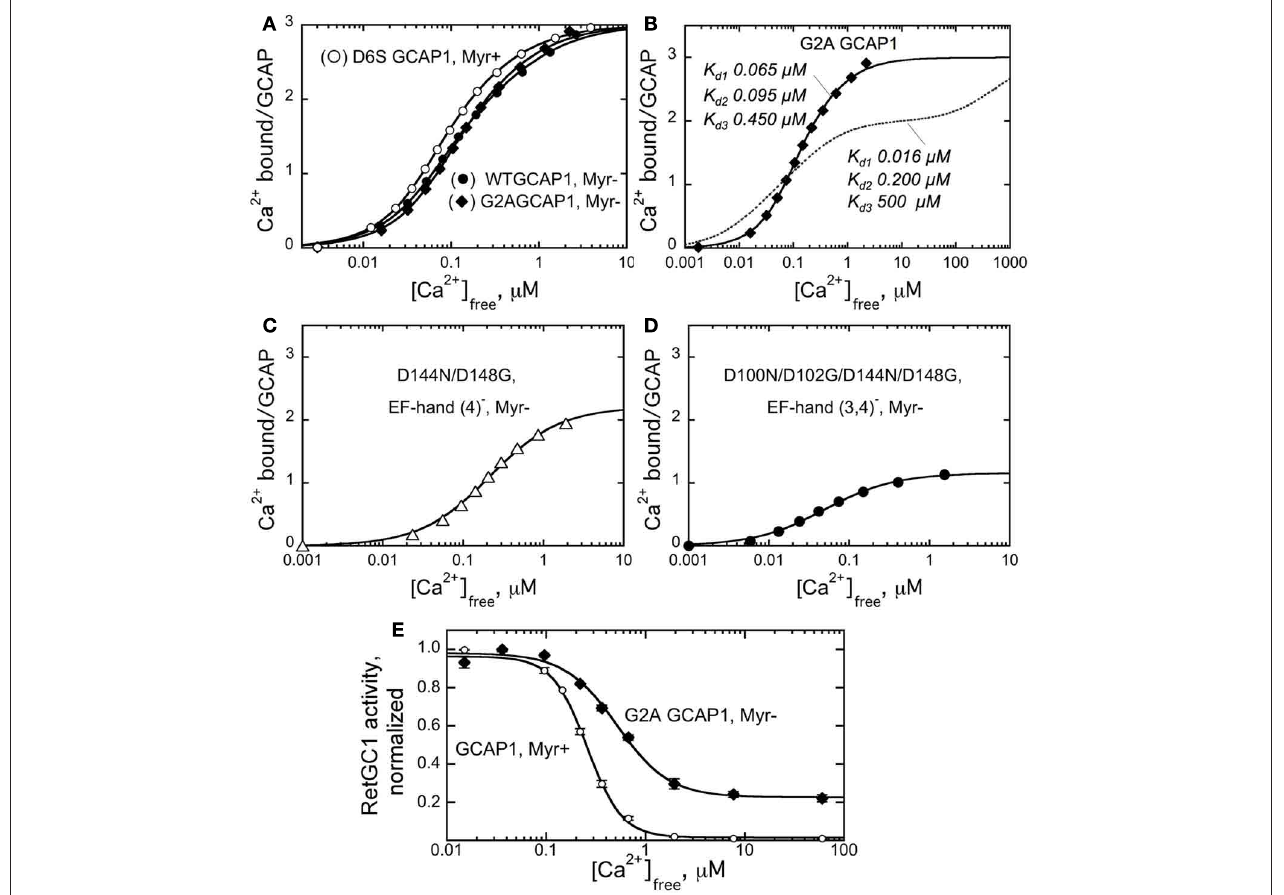
FIGURE 3 | Ca 2 + sensitivity of GCAP1 is affected by myristoylation. (A–D) , Ca 2 + binding isotherms obtained using fluorescent indicator dye BAPTA-2 titration protocol (Peshenko and Dizhoor, 2006). (A) Ca 2 + binding by myristoylated D6S GCAP1 ( ◦ ), non-myristoylated WT GCAP1 ( • ), and non-myristoylated G2A GCAP1 ( (cid:2) ). (B) Comparison of the experimental data for Ca 2 + binding by G2A GCAP1 ( (cid:2) ) with the theoretical curve for three-center binding model calculated using previously reported macroscopic association constants, 6 . 3 × 10 7 , 5 . 0 × 10 6 , and 2 . 0 × 10 3 M − 1 (Dell’Orco et al., 2010) (- - -); the corresponding dissociation constants are shown next to each trace. (C,D) Change of the binding stoichiometry in non-myristoylated GCAP1 with one (D144N/D148G, C ) or two (D100N/D102G/D144N/D148G, D ) EF-hands inactivated. The data were fitted using two different models: panels (A,B) —by three-center binding model, Ca bound /GCAP = ( K 1 Ca f + 2 K 1 K 2 Ca 2 f + 3 K 1 K 2 K 3 Ca 3 f )/( 1 + K 1 Ca f + K 1 K 2 Ca 2 f + K 1 K 2 K 3 Ca 3 f ), where K 1 , K 2 , and K 3 are macroscopic equilibrium